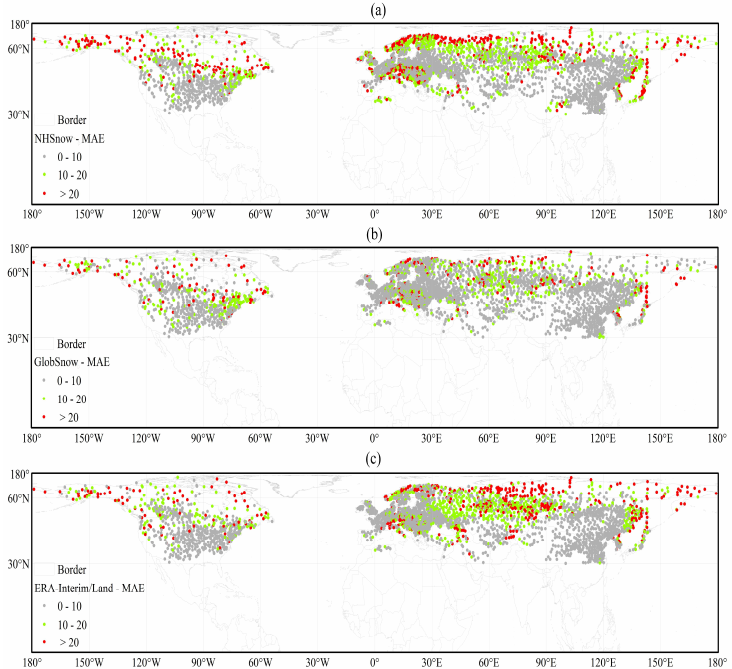
Figure 4. Mean absolute error (MAE) of each meteorological station for three snow cover datasets: ( a ) NHSnow, ( b ) GlobSnow, and ( c ) ERA-Interim/Land. The site MAE is calculated based on all of the valid records in each station during 1992–2010 (December to February). Remote Sens. 2020 , 12 , x FOR PEER REVIEW